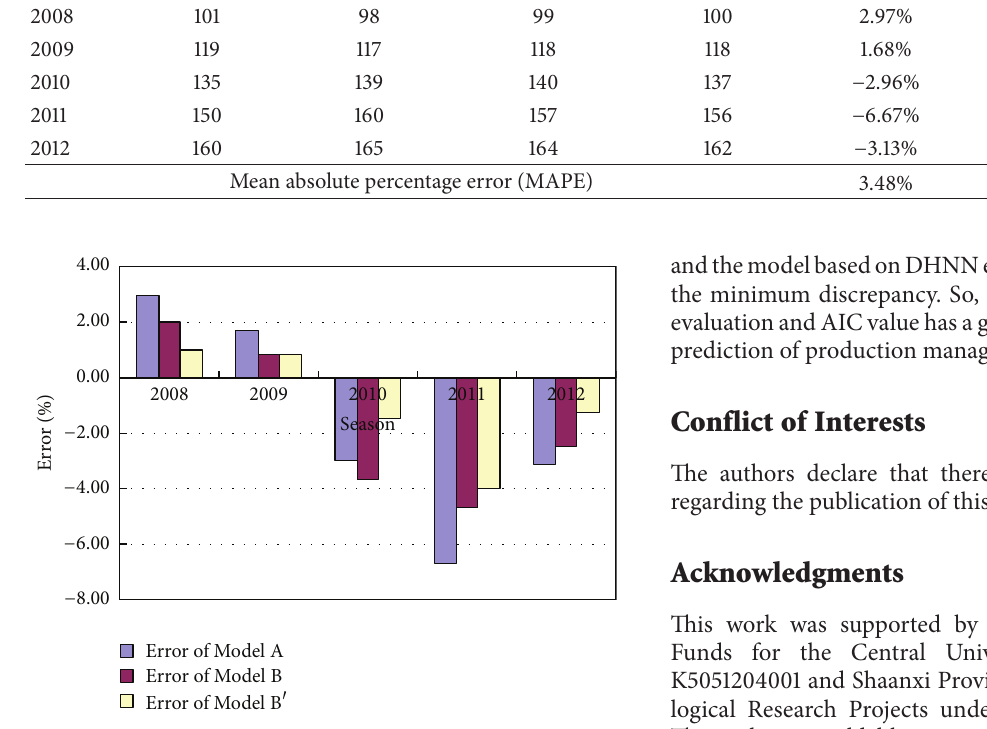
Figure 4: Error comparison of Model A, Model B, and Model B 󸀠 .